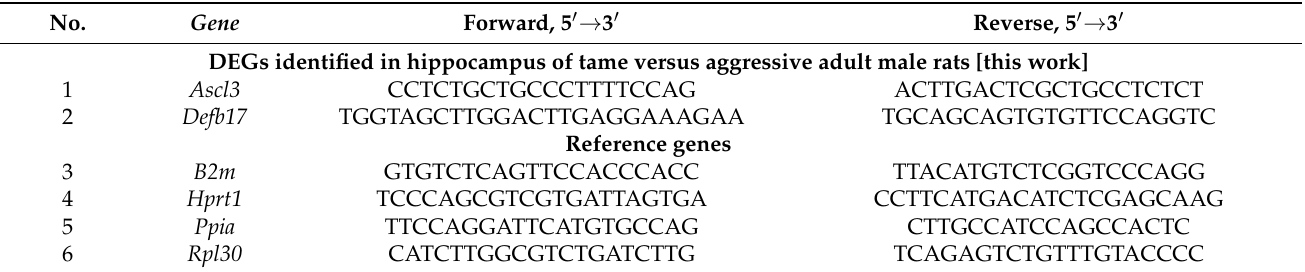
Table 12. qPCR primers selected using publicly available Web service PrimerBLAST [240]. No. Forward, 5 (cid:48) → 3